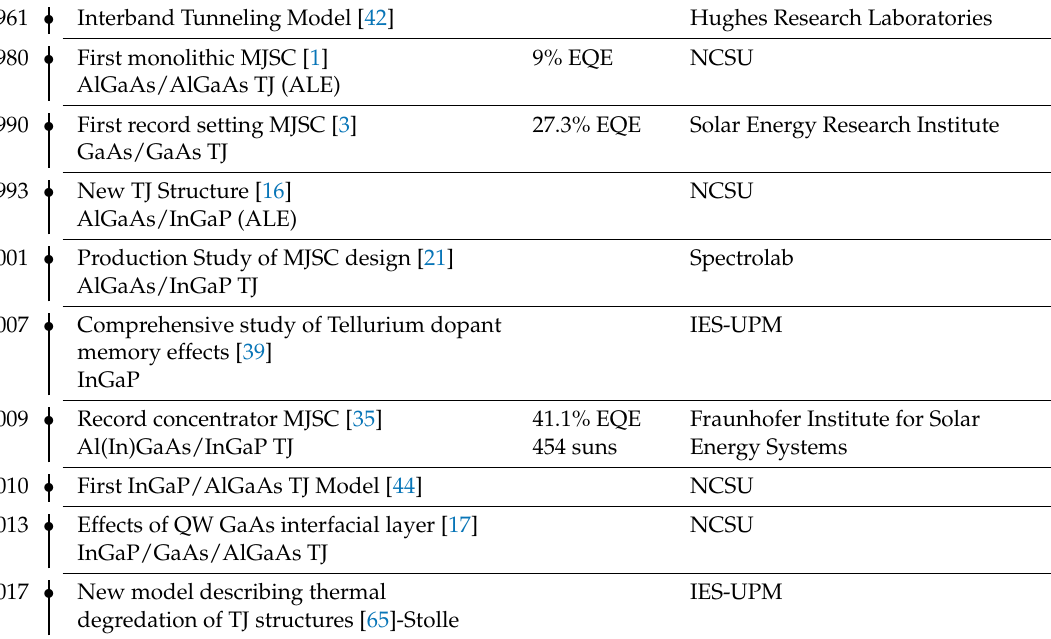
Table 1. Timeline of Notable